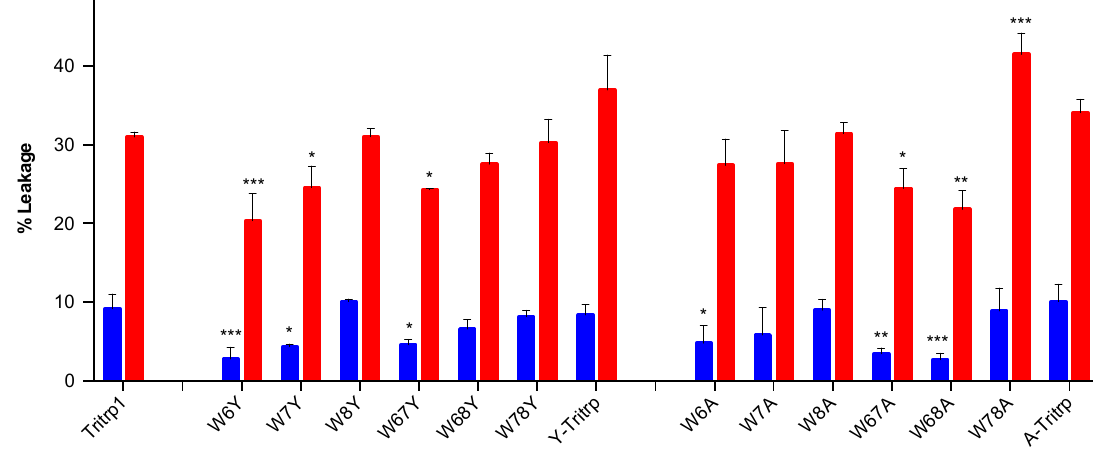
Figure 5. Calcein leakage results for Tritrp1 and its analogs in the presence of ePC:ePG (1:1) vesicles. Two different peptide/lipid (P/L) ratios are depicted as taken from Figure 4, 0.025 (blue) and 0.1 (red). Results are the mean ± SD ( n =